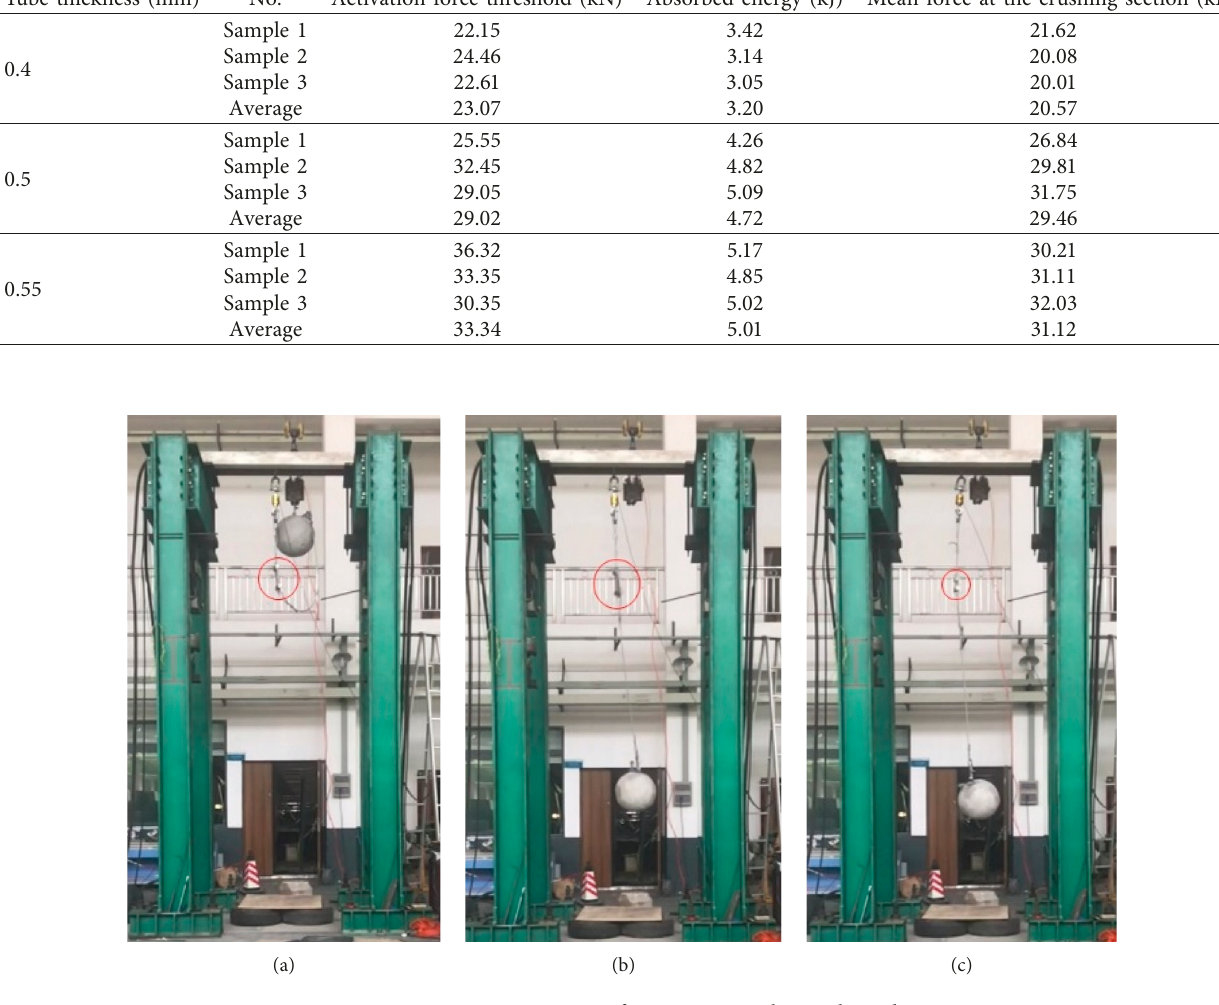
Figure 13: Dynamic impact process of a symmetric tube-crushing